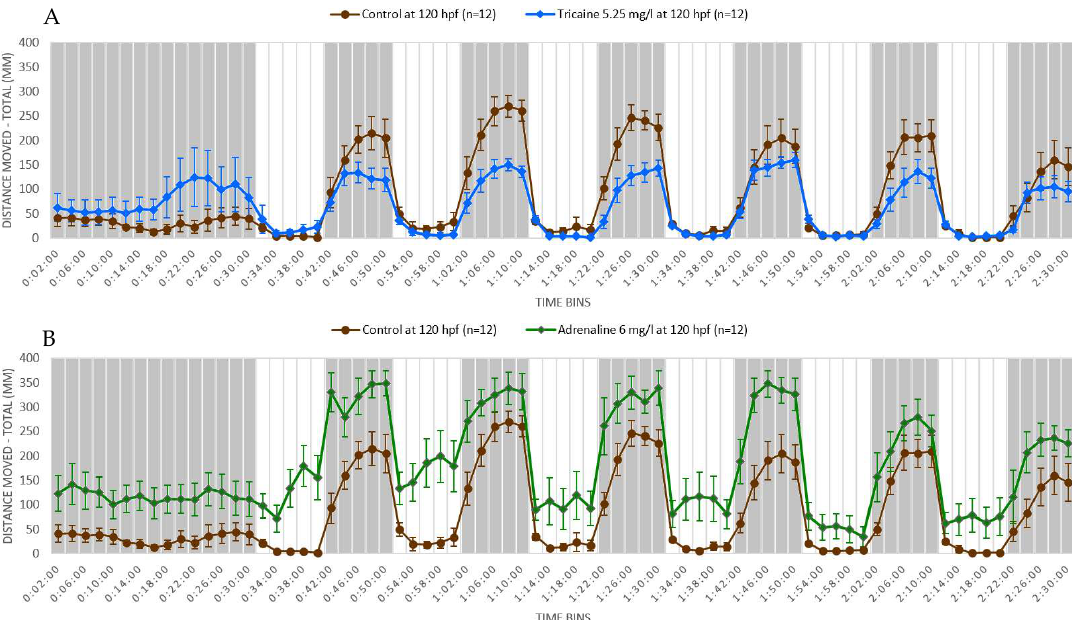
Figure 2. Swimming pattern of AB wild type zebrafish larvae after drug treatment. Zebrafish larvae ( n = 12 for each drug) at 5 dpf were exposed to sterile water (used as control), adrenaline 0.03 mM (6 mg/L), and tricaine 0.02 mM (5.25 mg/L). The total volume of drug solution or sterile water used was 300 µ L per well. The exposure was started half an hour before the experiment and continued till the conclusion of the experiment. The experiment protocol was the same as described in Figure 1. The results were calculated as mean ± SEM of the distance moved by each experimental group in 2 min of time bins. Adrenaline-treated zebrafish larvae showed increased movement throughout the experiment ( A ). On the contrary, tricaine-treated zebrafish larvae showed decreased movement throughout the experiment ( B ). n = 12 for each experimental group.